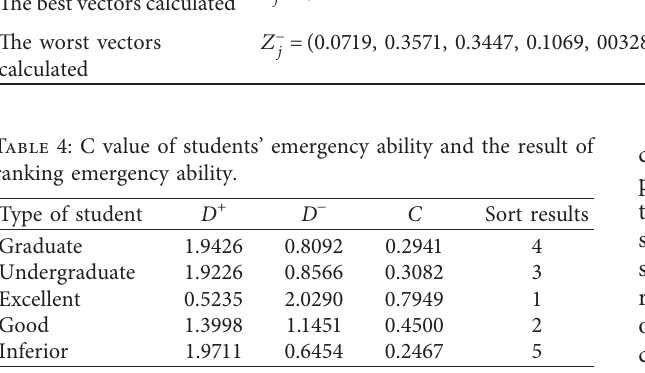
Table 3: The best and worst vectors calculated based on the emergency situation and the TOPSIS model method. Name of vectors Concrete vector